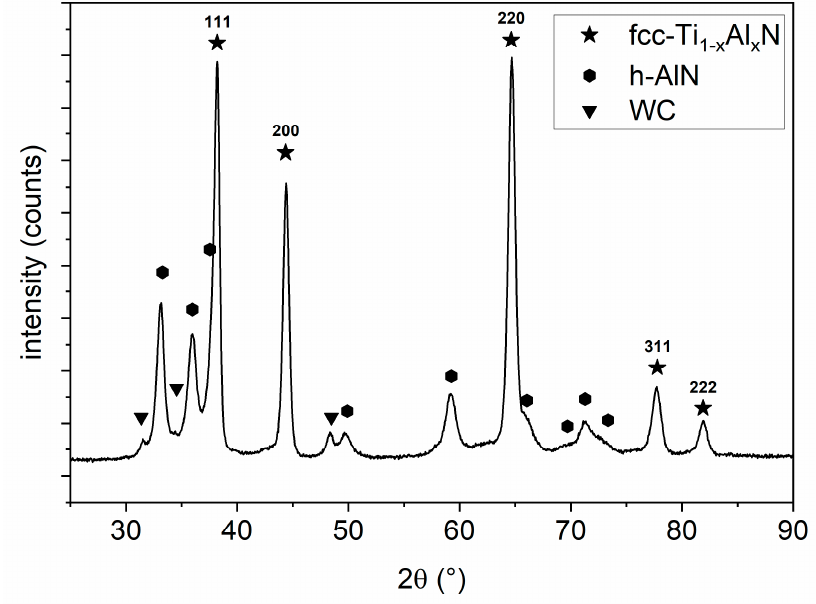
Figure 2. XRD diffractogram (GAXRD, φ = 3°) of the Ti 1-x Al x N coating on the WC-Co substrate. The XRD diffractogram of the Ti 1 − x Al x N coating on the WC-Co substrate shows the peaks of the fcc-Ti 1 − x Al x N phase, as well as a substantial fraction of about 15 wt.% hexagonal AlN. This points to an increasing phase fraction of hexagonal AlN caused by a depletion of the titanium-containing reactants in the direction of the flow of gas. This means that a pure fcc-Ti 1 − x Al x N phase is only obtained in the front and middle parts of the steel foil. This is shown later by the analyses under point 3.2. A stress-free lattice